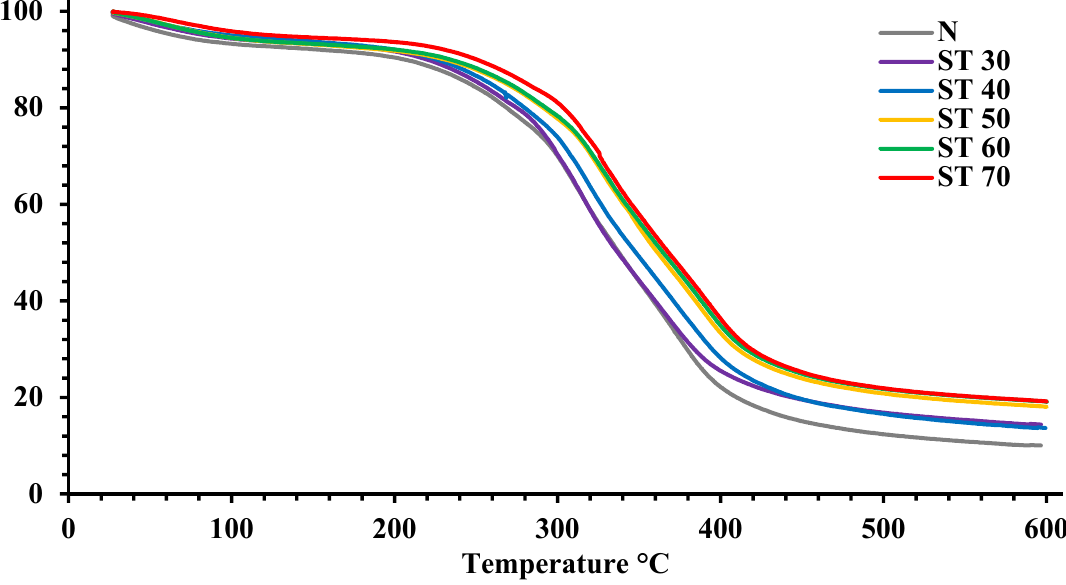
Figure 2. Thermal gravimetric analysis of N: native plum kernel protein isolate; ST 30: supercritical carbon dioxide (SC-CO 2 )-treated plum kernel protein isolate at 30 °C; ST 40: SC-CO 2 -treated plum kernel protein isolate at 40 °C; ST 50: SC-CO 2 -treated plum kernel protein isolate at 50 °C; ST 60: SC-CO 2 -treated plum kernel protein isolate at 60 °C and ST 70: SC-CO 2 -treated plum kernel protein isolate at 70 °C.